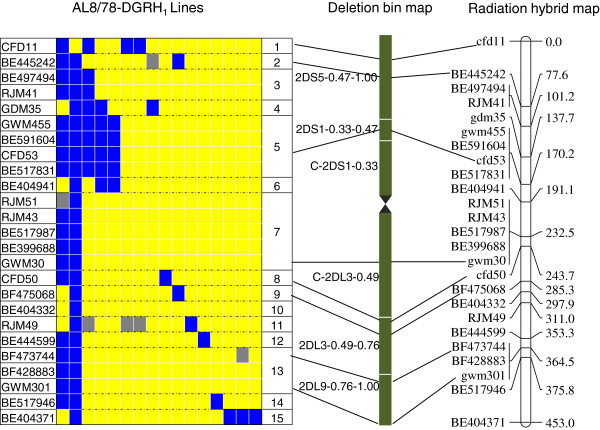
A radiation hybrid map of chromosome 2D (right). Also shown (left) is the graphical genotype for a panel of sixteen RH lines with deletions that dissected chromosome 2D into 15 different RH bins. Solid yellow squares indicate that the marker was present in the particular RH1 line. Solid blue squares indicate that the marker was absent in the particular RH1 line. Solid grey squares indicate missing information.